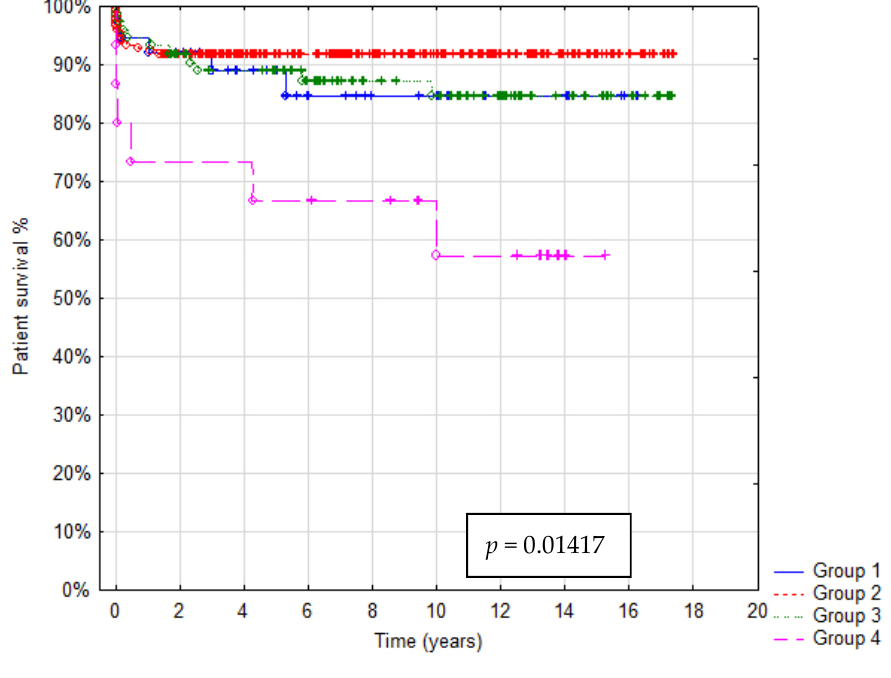
Figure 2. Kaplan–Meier patient survival curve.